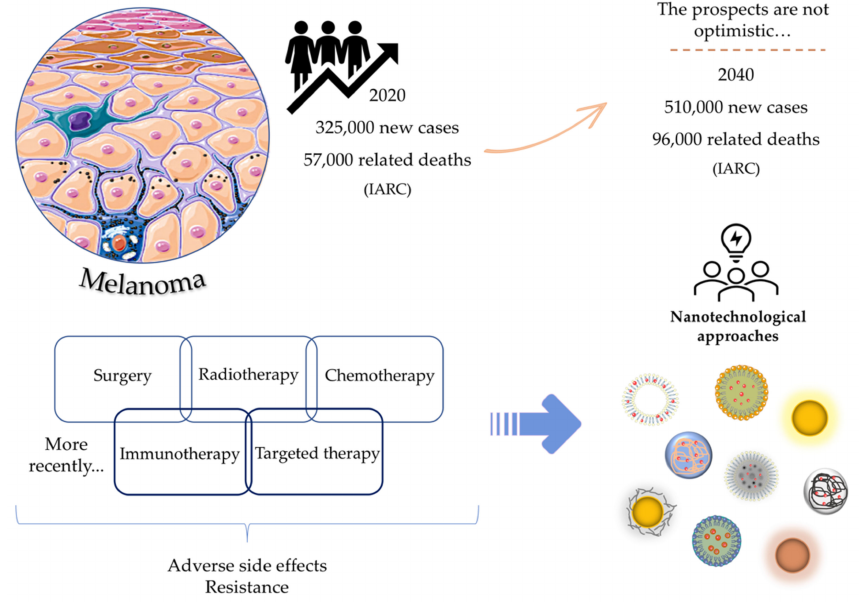
Figure 1. Melanoma: epidemiological data, current therapies and new alternative strategies for improving clinical